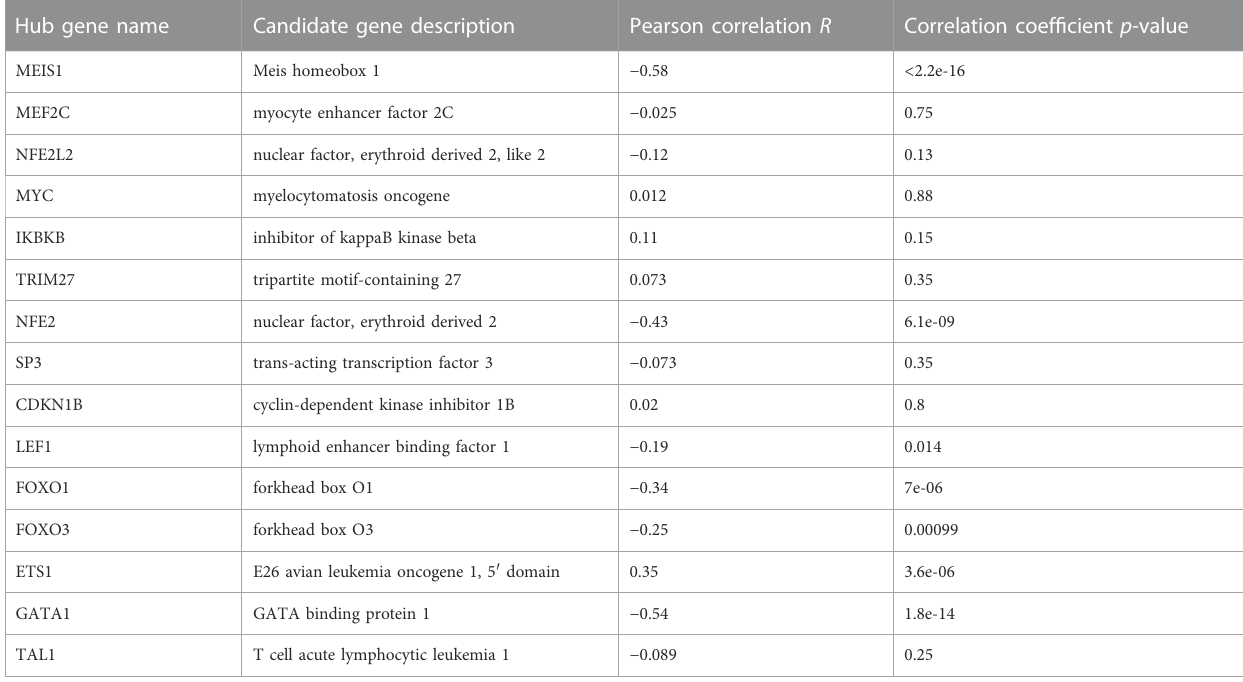
TABLE 2 Correlation between gene expression and methylation level of candidate genes in AML patients. Hub gene